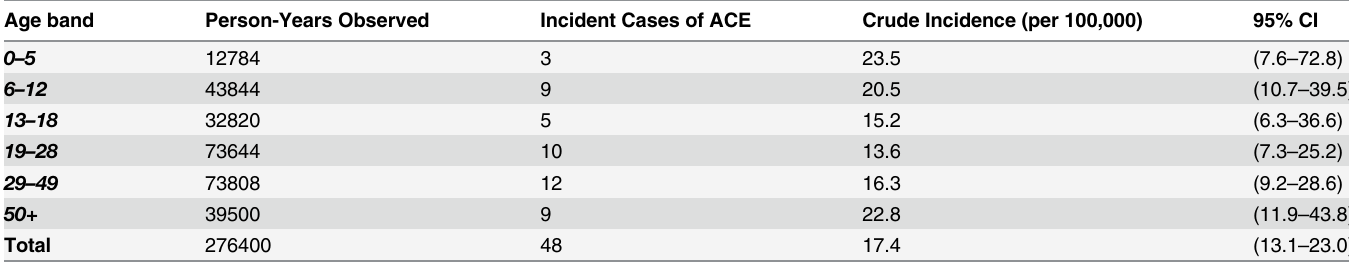
Table 2. Crude incidence of convulsive epilepsy by age band, Agincourt 2012. Age